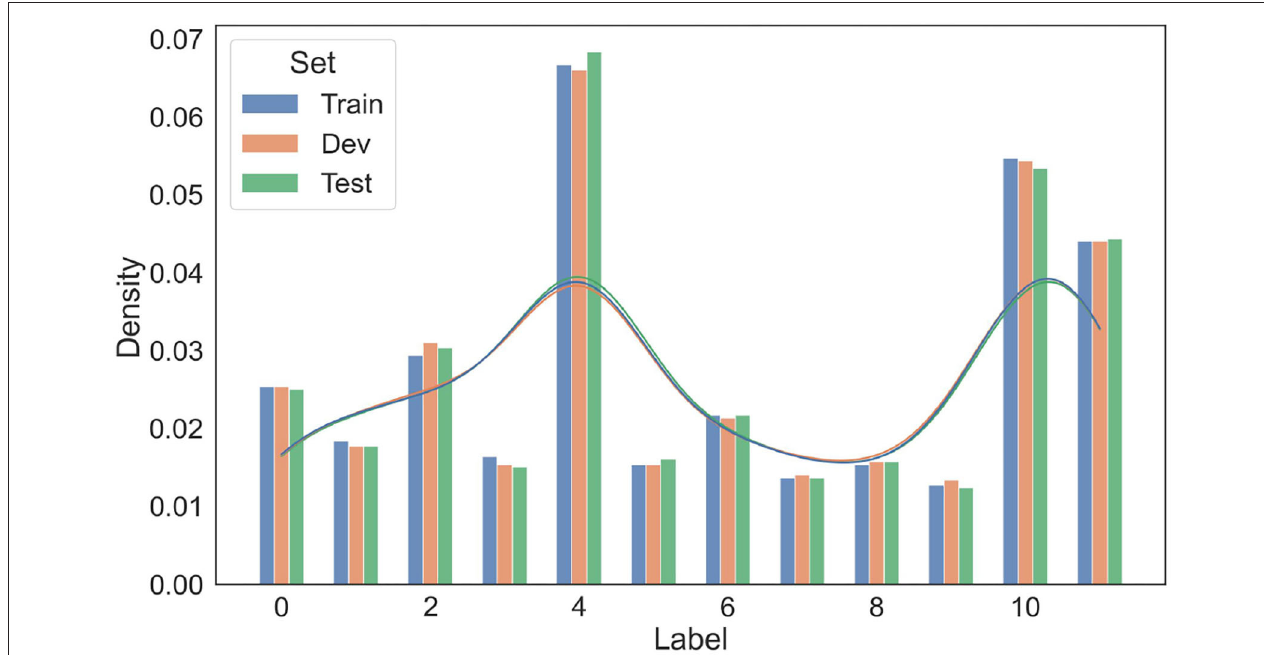
FIGURE 4 | Distributions of entity labels on the training/development/test data splits. The labels are indexed according to their order in Table 4 .